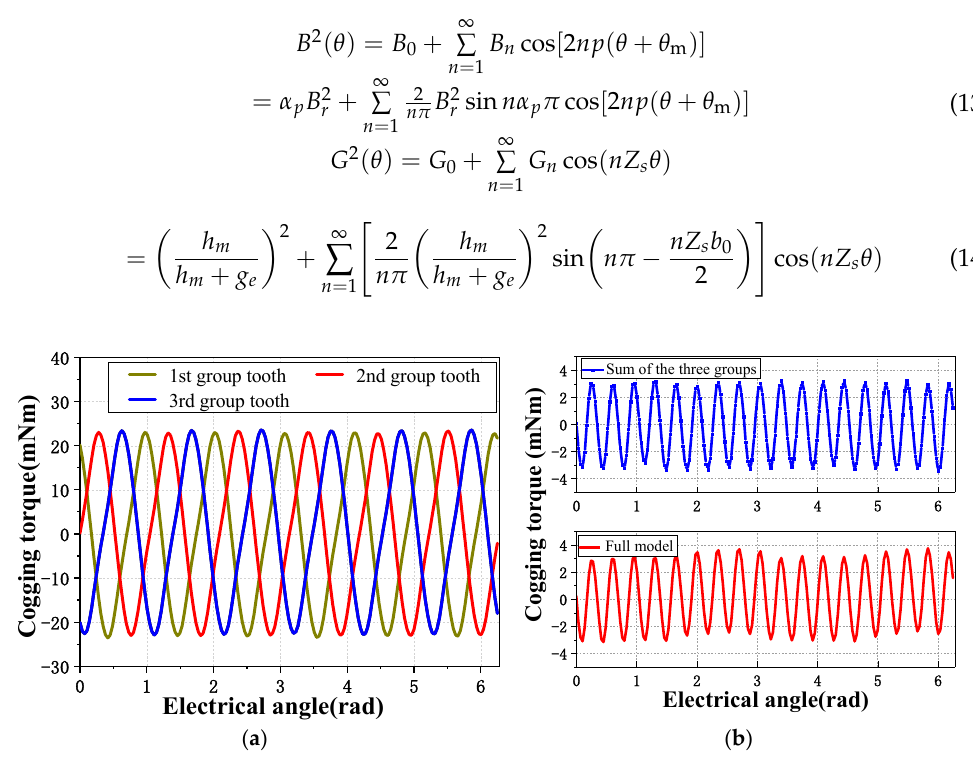
Figure 7. Cogging torque verification of proposed method by FEM: ( a ) each group ( b ) sum compar- ison.